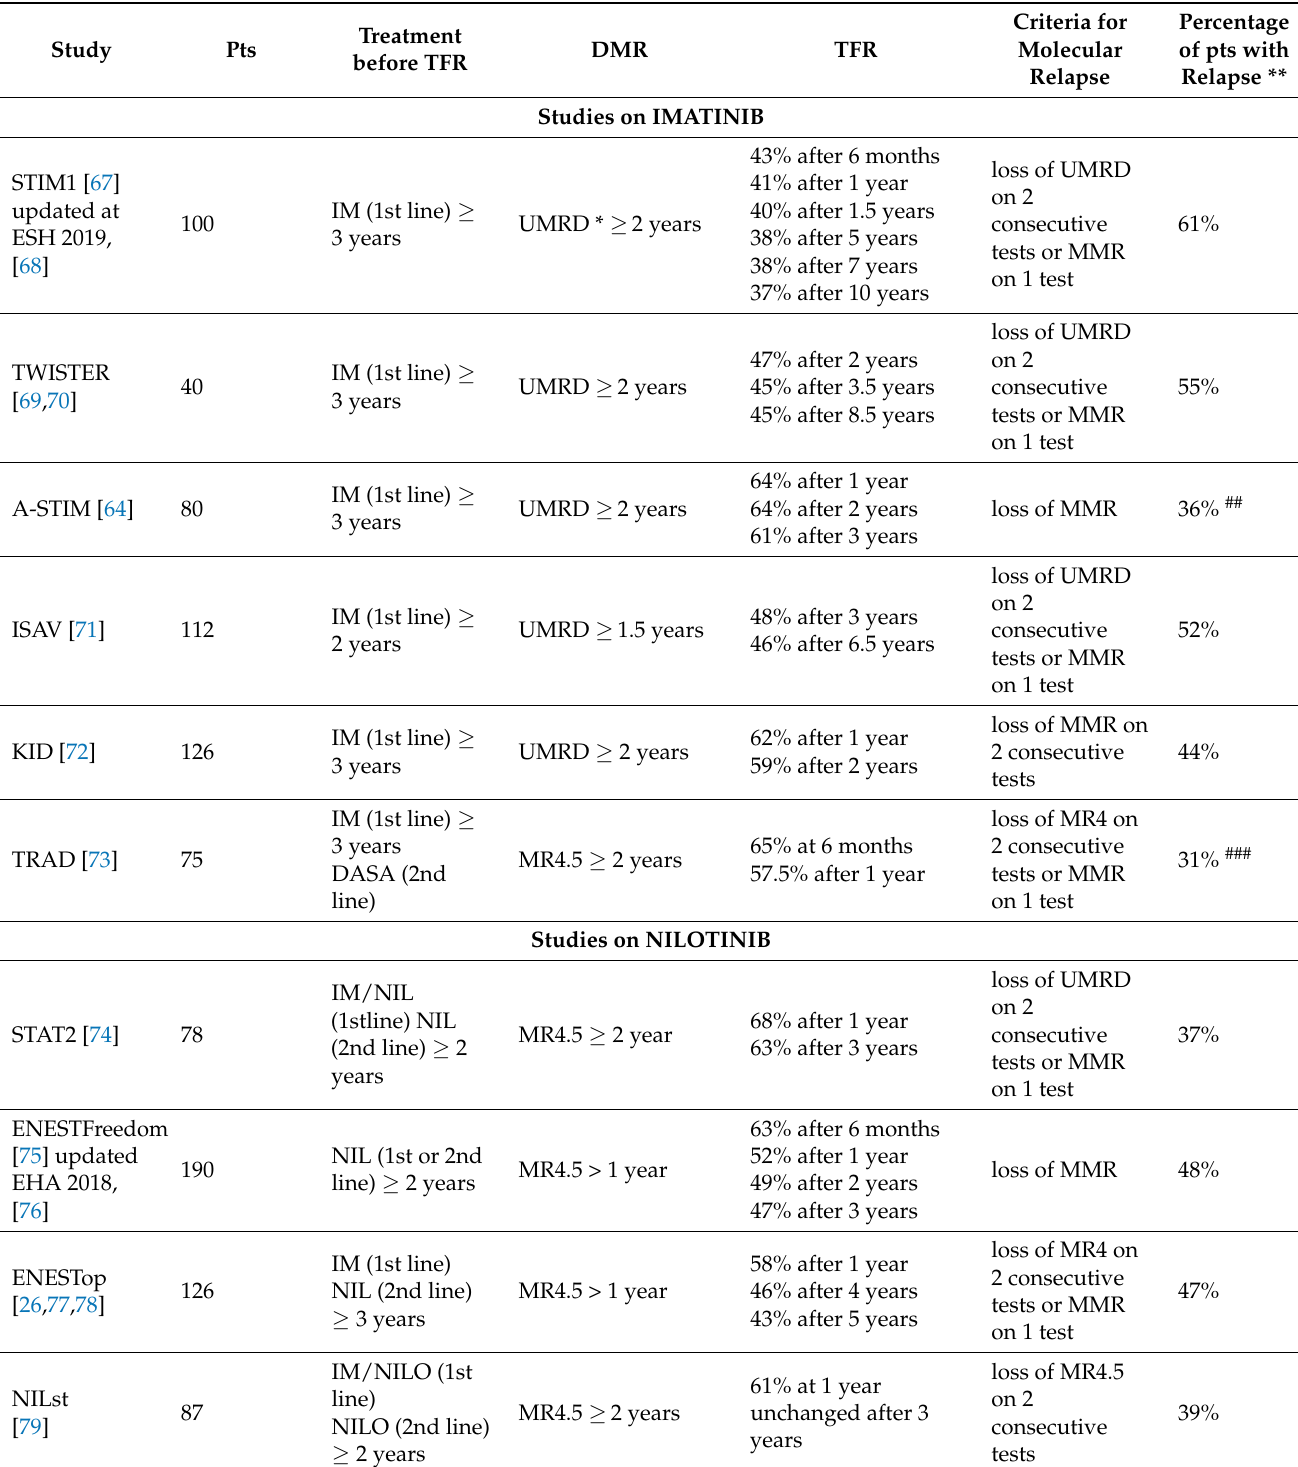
Table 3. Clinical trials of